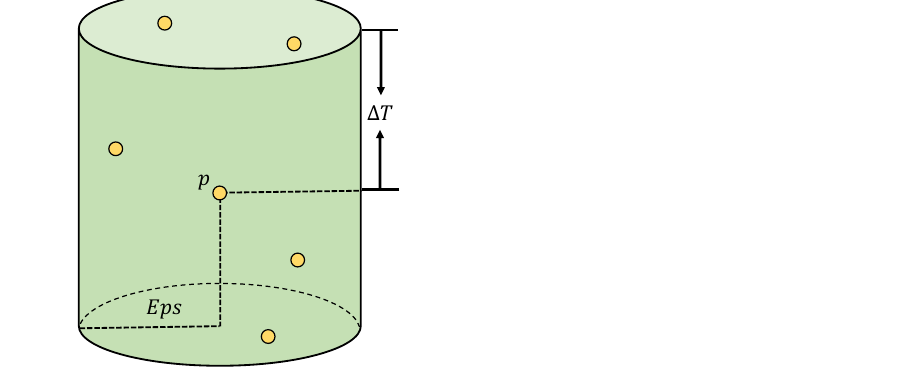
Algorithm inputs: sample data set D , spatial radius parameter Eps , time